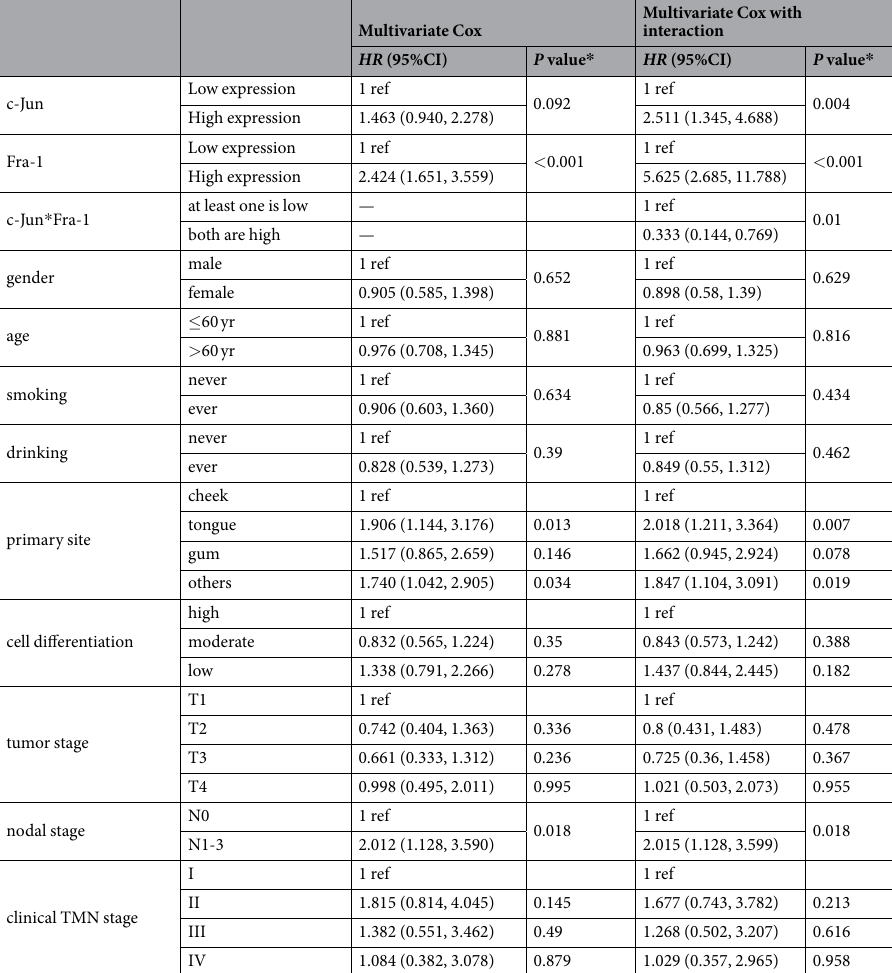
Table 3. Multivariate analysis of OSCC patients’ overall survival at 5